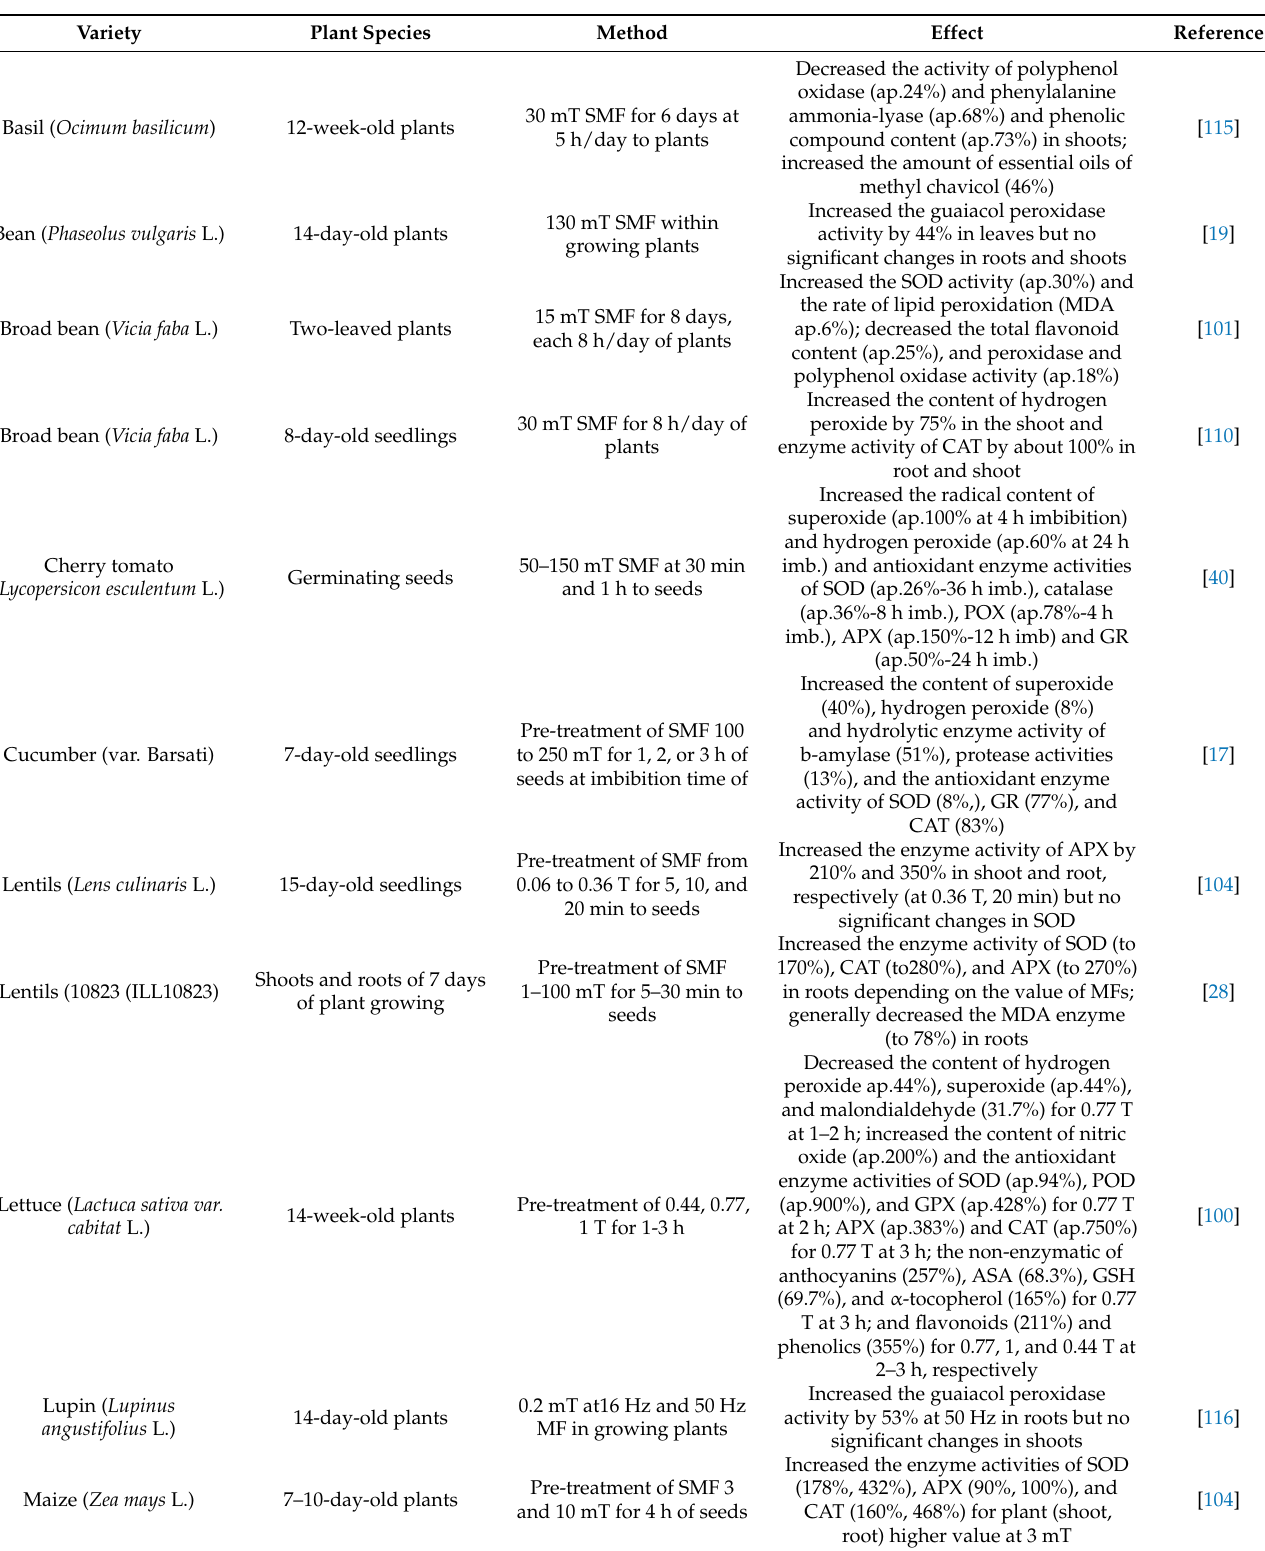
Table 2. Effects of MFs on reactive oxygen species, nitric oxide content, and enzyme